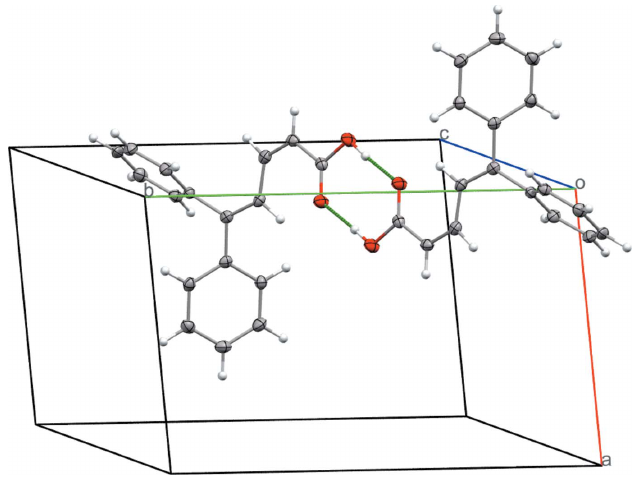
Figure 2 Packing of the molecules with O—H (cid:3)(cid:3)(cid:3) O hydrogen bonds shown as green dashed